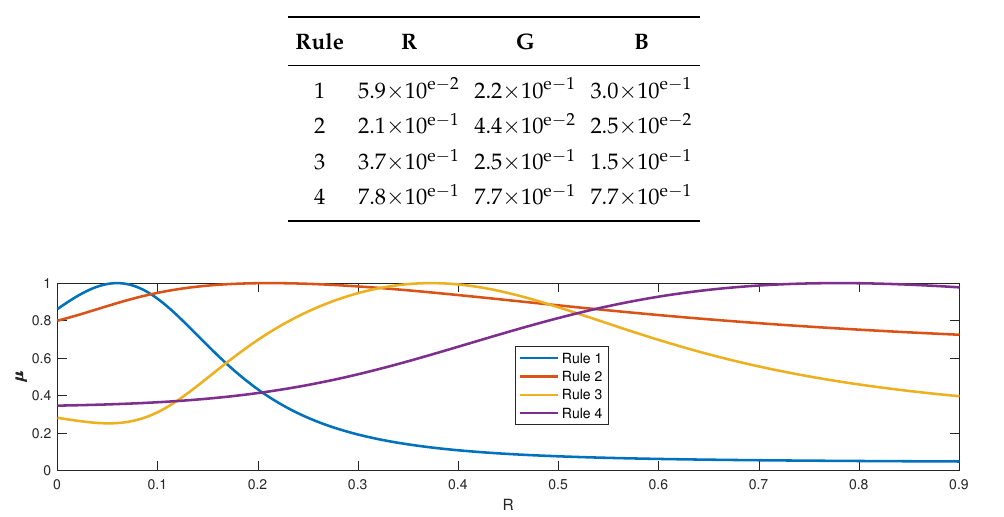
Figure 12. Spectral curves associated to cluster centers obtained in the FIS using RGB data. For each center, the curve is plotted using the RGB coordinates associated to the color represented by the curve itself for illustrative purposes. Table 3. Cluster centers for RGB values.